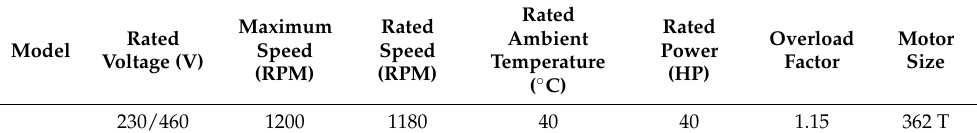
Figure 4. Centrifugal pump experimental system. Table 1. Motor parameters.